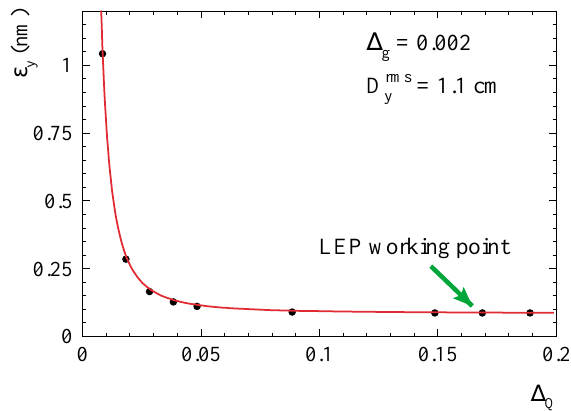
FIG. 1. (Color) Simulated dependence of the vertical emittance ´ y for LEP as a function of the distance D Q of the tunes from the difference coupling resonance. The beam energy is 100 GeV and the horizontal emittance is ´ x (cid:1) 44 (cid:1) nm (cid:2) . The LEP working point corresponds to D Q (cid:1) 0.17 with horizontal tune Q x (cid:1) 98.35 and vertical tune Q y (cid:1) 96.18